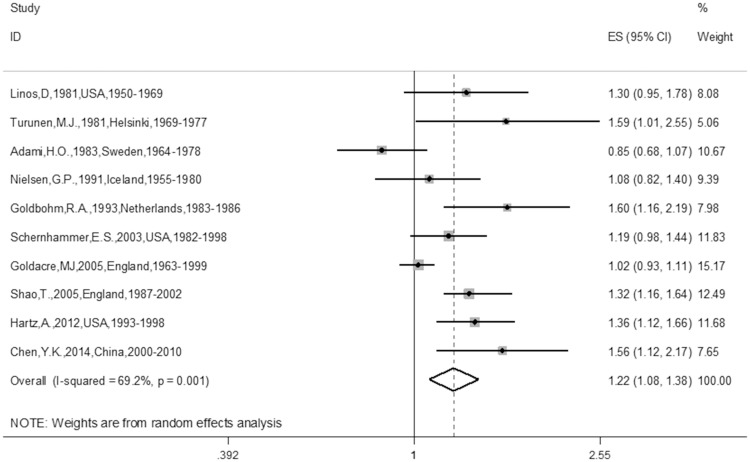
Forest plot of risk of CRC associated with cholecystectomy in general population.Note: CRC represents colorectal cancer.